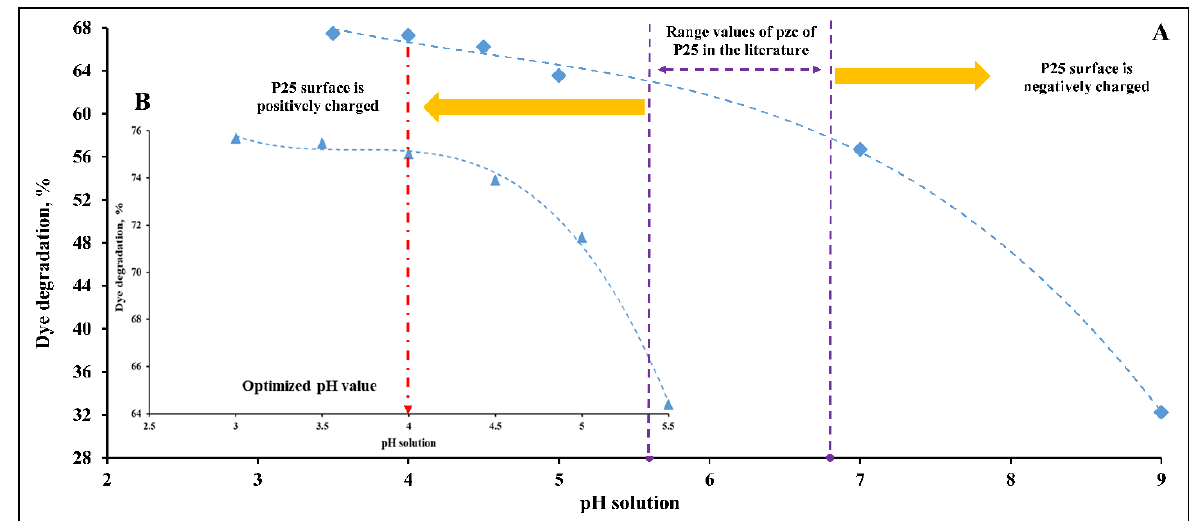
Figure 5. pH optimization for DB15 degradation at catalyst concentration 0.5 g/L, light intensity 11.2 W/m 2 and two different dye concentrations: ( A ) Dye concentration 25 mg/L, ( B ) Dye concentration 20 mg/L.